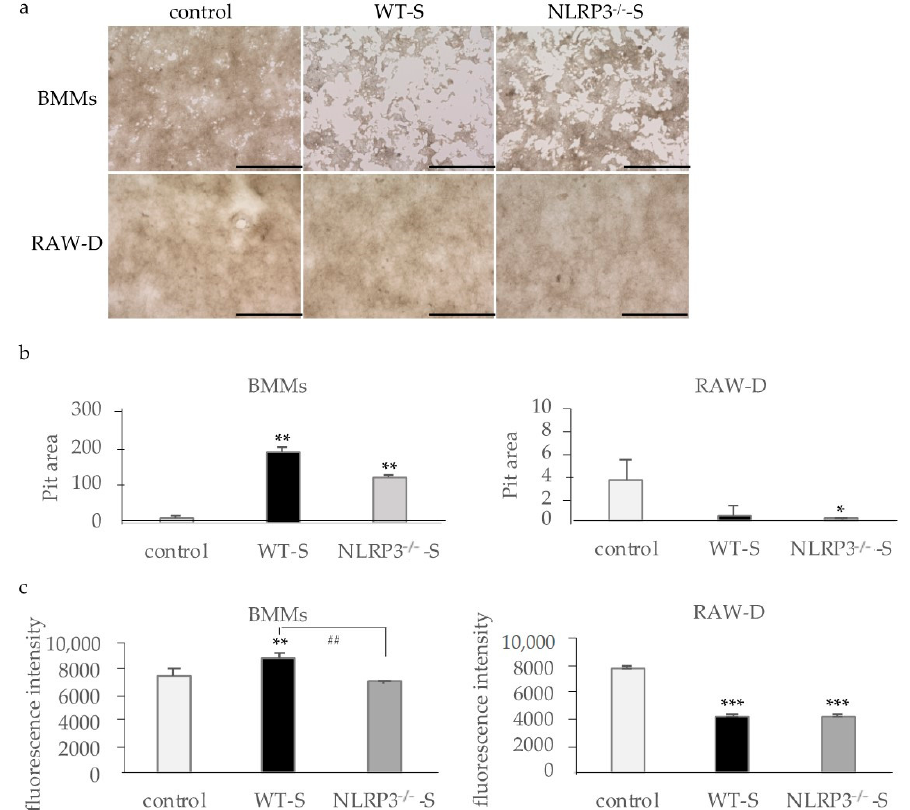
Figure 2. Evaluation of osteoclast bone resorption capacity. BMMs were incubated with 30 ng/mL M-CSF and 20 ng/mL RANKL for 48 h. Then, the cells were incubated for 72 h with the same concen- trations of M-CSF, RANKL, and the culture supernatant of WT or NLRP3 − / − mouse macrophages stimulated with DC. RAW-D cells were incubated with 20 ng/mL RANKL for 48 h. Then, the cells were incubated for 72 h with the same concentrations of RANKL and the culture supernatant of WT or NLRP3 − / − mouse macrophages stimulated with DC. After removing the supernatants, the calcium- coated plate was treated with 5% sodium hypochlorite to remove the cells ( a ), and the pit area was measured with ImageJ ( b ). The bone resorption capacity was also analyzed by measuring the fluo- rescence intensity of the supernatants ( c ). Scale bar = 500 μ m. The differences between the groups were analyzed by one-way ANOVA followed by a Tukey test for multiple comparisons. * p < 0.05 ** p < 0.01 *** p < 0.001 compared with the control. ## p < 0.01 compared among the test groups. BMM, bone marrow macrophage; DC, dental calculus; NLRP3 -/- -S, culture supernatant of the NLRP3-defi- cient mouse macrophages stimulated with DC; WT, wild-type; WT-S, culture supernatant of the wild-type mouse macrophages stimulated with DC.